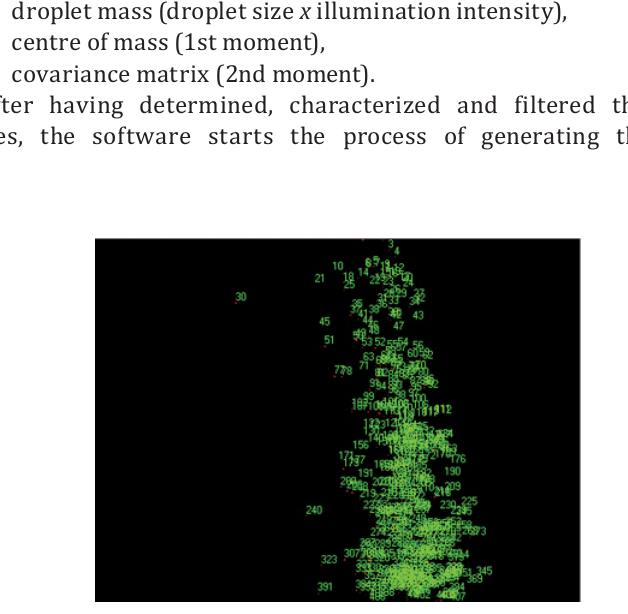
Figure 7. Segmented digital picture from image processing software with identified water